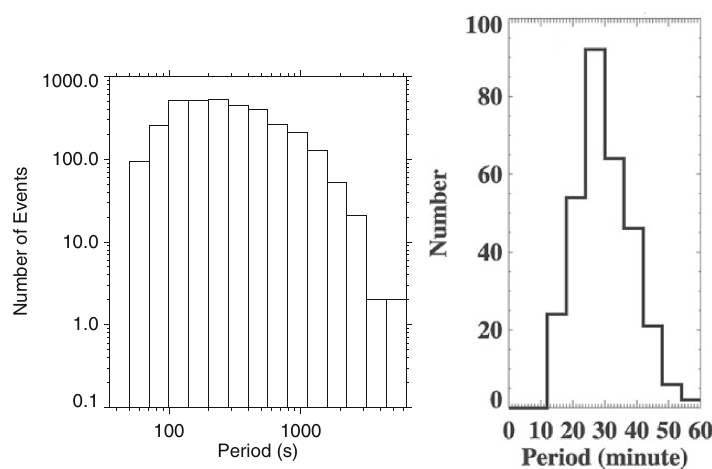
Fig. 9 Left: Hinode/SOT H α observation of transverse thread oscillations in a quiescent prominence. Histogram of the initial period, P 0 of Eq. (8). Image reproduced with permission from Hillier et al. (2013), copyright by AAS. Right: SDO/AIA 171 Å observation of transverse oscillations of barbs belonging to a polar crown prominence. Histogram of the period. Image reproduced with permission from Li and Zhang (2013), copyright by